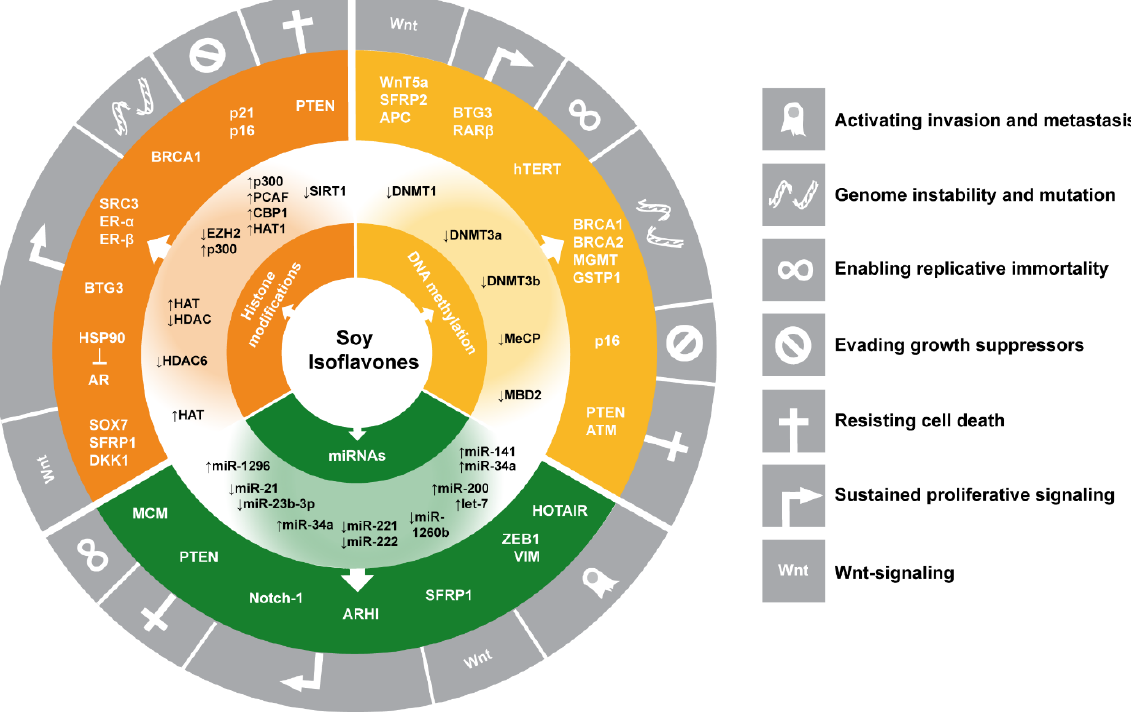
Figure 3. Soy IF target several “hallmarks of cancer” through epigenetic